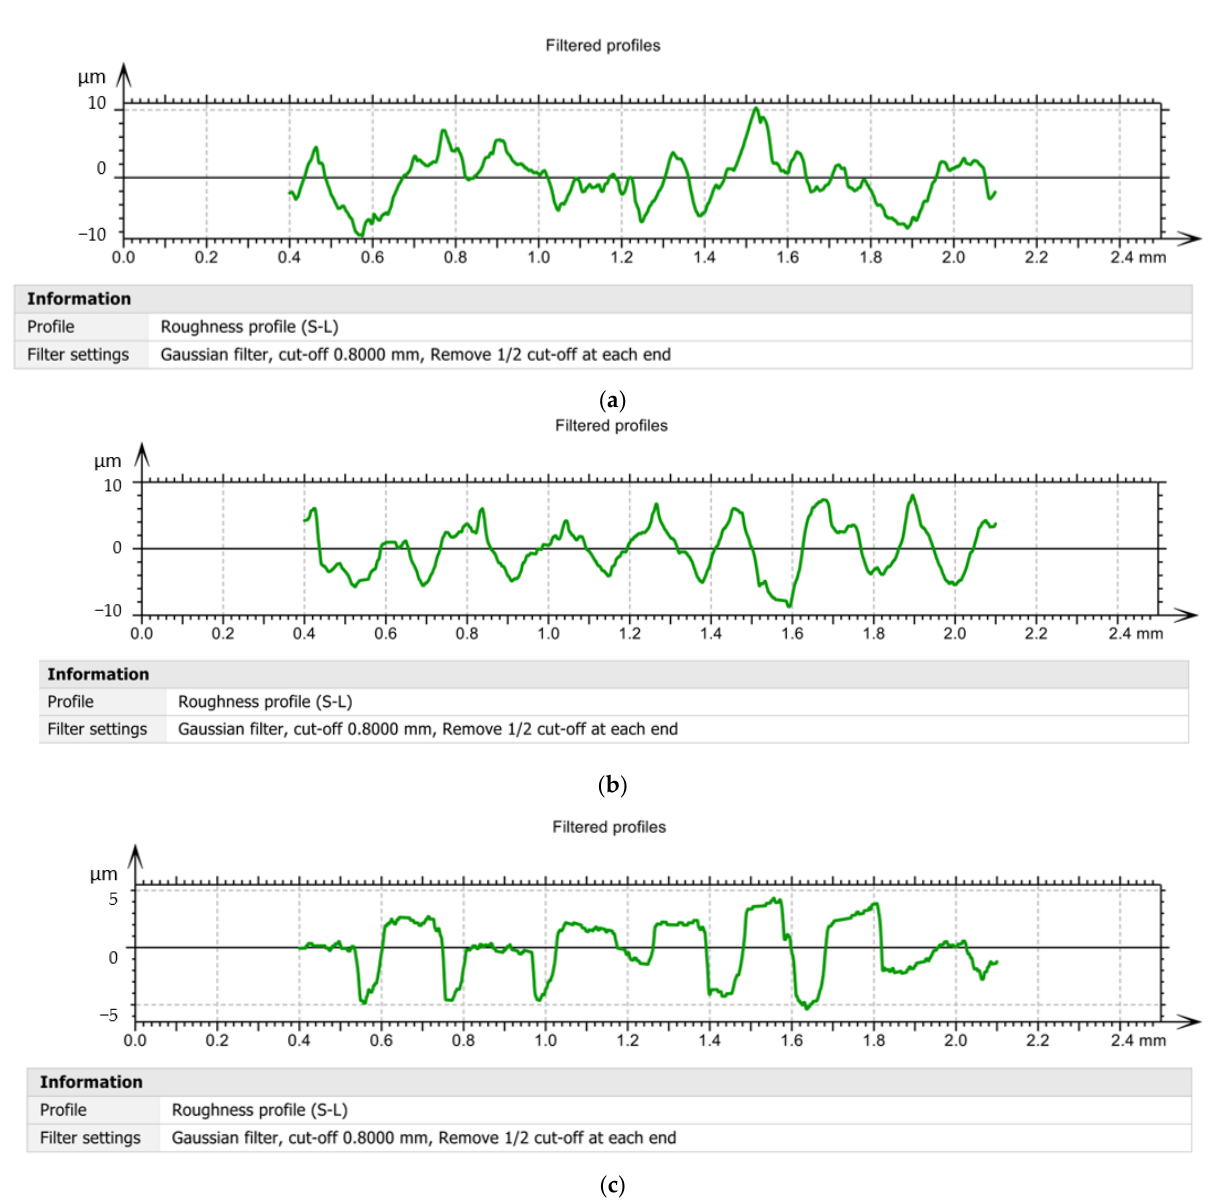
Figure 9. Filtered profiles: ( a )—in the case of machining with a V01 cutting tool; ( b )—in case of machining with V02 cutting tool; ( c )—in case of machining with cutting tool V03.